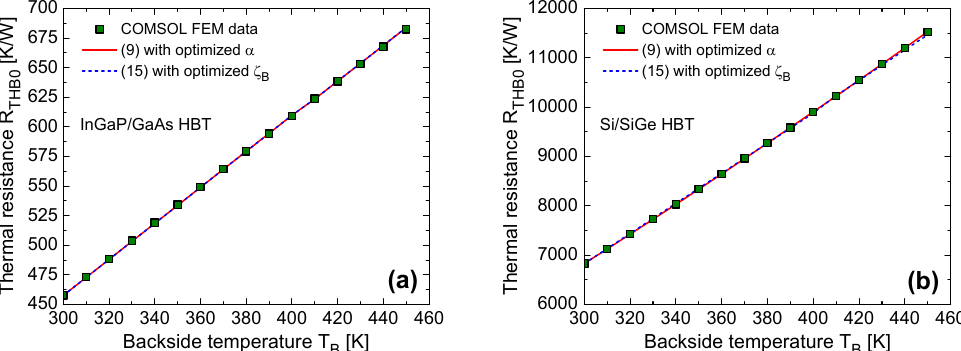
Figure 5. Zero-power thermal resistance R THB 0 as a function of T B for ( a ) the InGaP/GaAs HBT and ( b ) the Si/SiGe HBT. COMSOL data (symbols) are compared to (9) with optimized α (solid red line) and (15) with calibrated ζ B (dashed blue line).